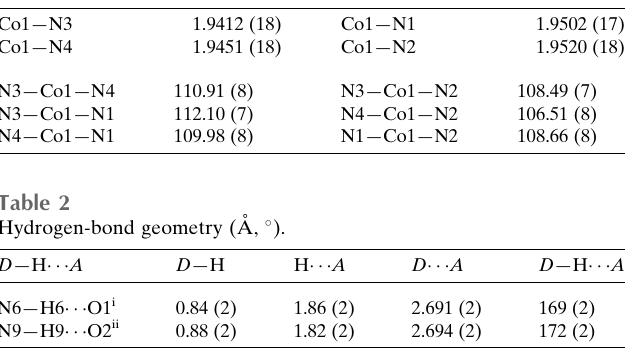
Table 1 Selected geometric parameters (A˚ , (cid:4) ).